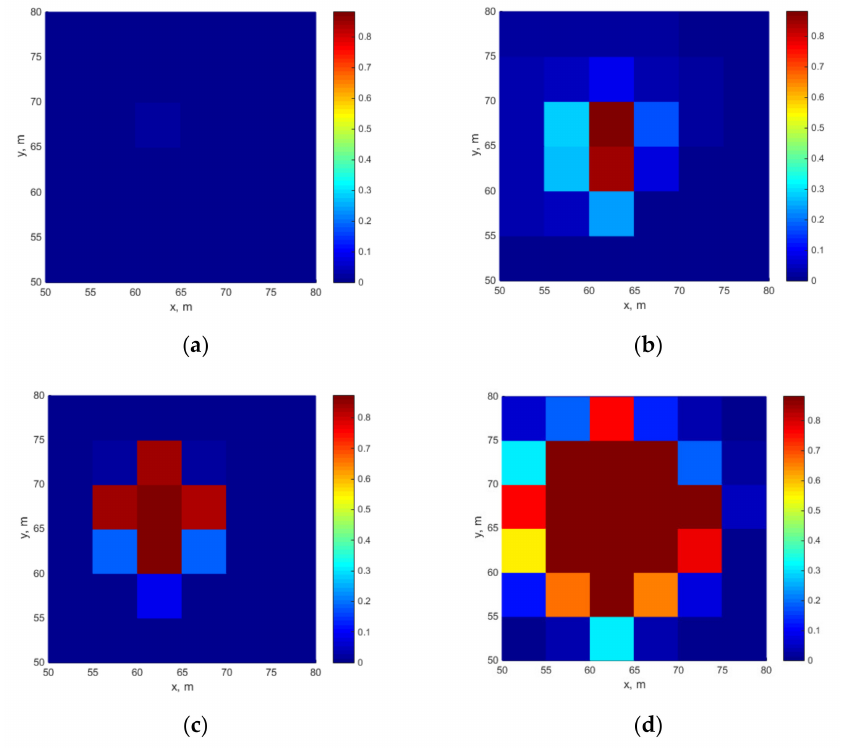
Figure 13. Profiles of the concentration of IC2 light component in gas phase: ( a ) 400 days, upper layer; ( b ) 800 days, upper layer; ( c ) 400 days, lower layer; ( d ) 800 days, lower